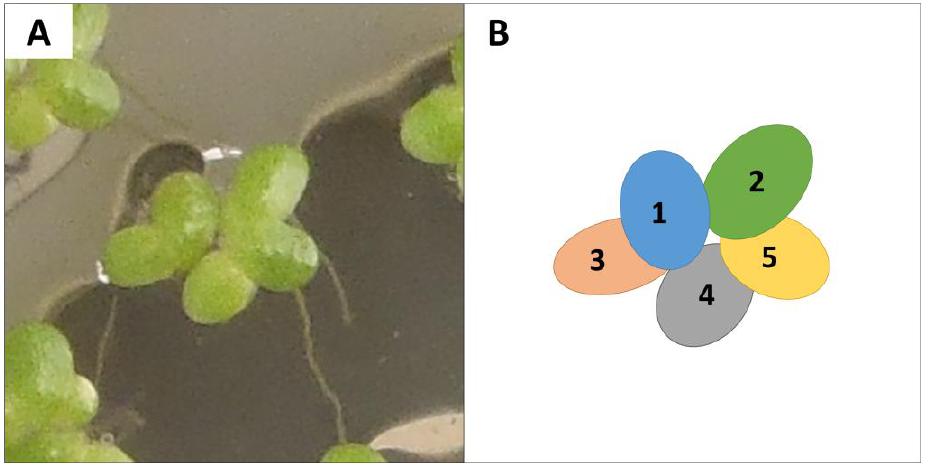
Figure 4. Image of a live Lemna minor colony ( A ) and diagram depicting how we differentiated and counted fronds ( B ).